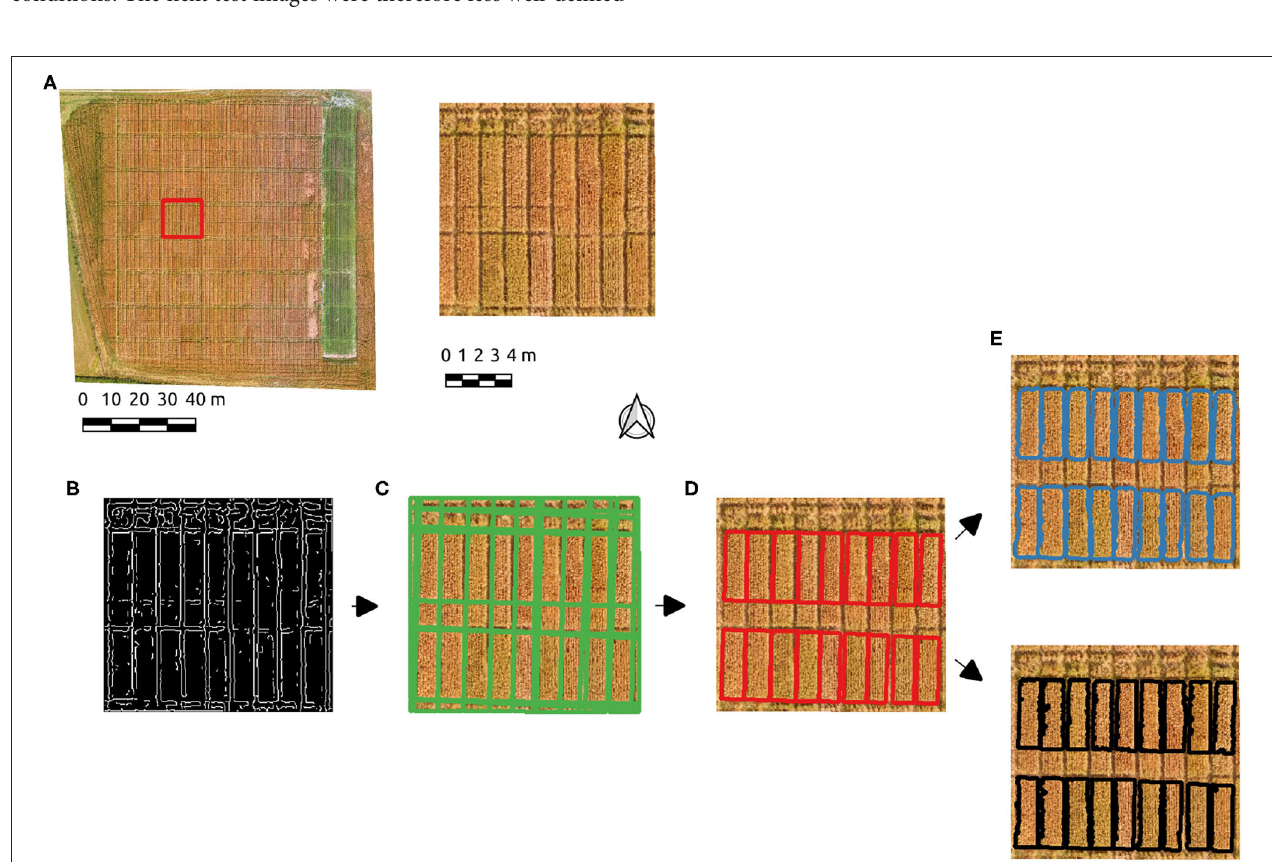
FIGURE 3 | The experimental workflow results; (A) the test image subset used, (B) Canny edge detection, (C) Hough line detection results, (D) polygon elimination, (E) active contour (blue) and Otsu-based (black) boundary refinement results.